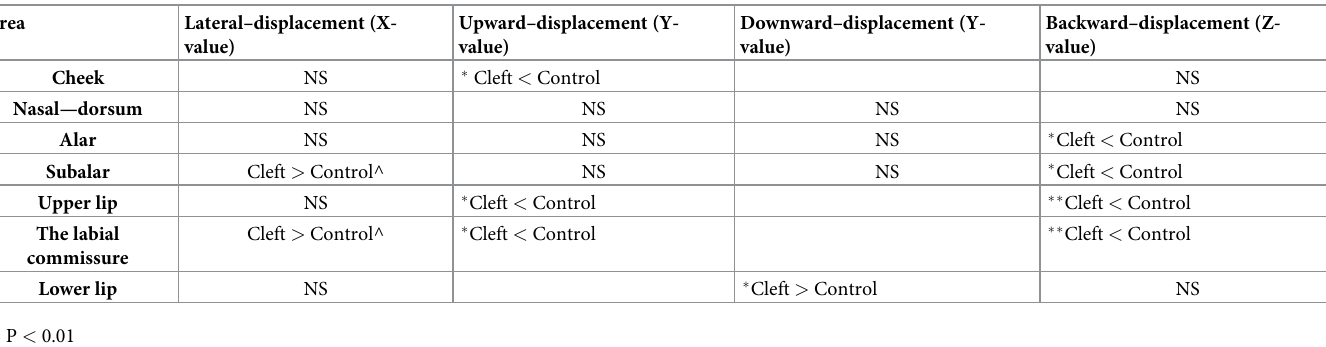
Table 3. Summary of the displacement while smiling on the cleft side in the two